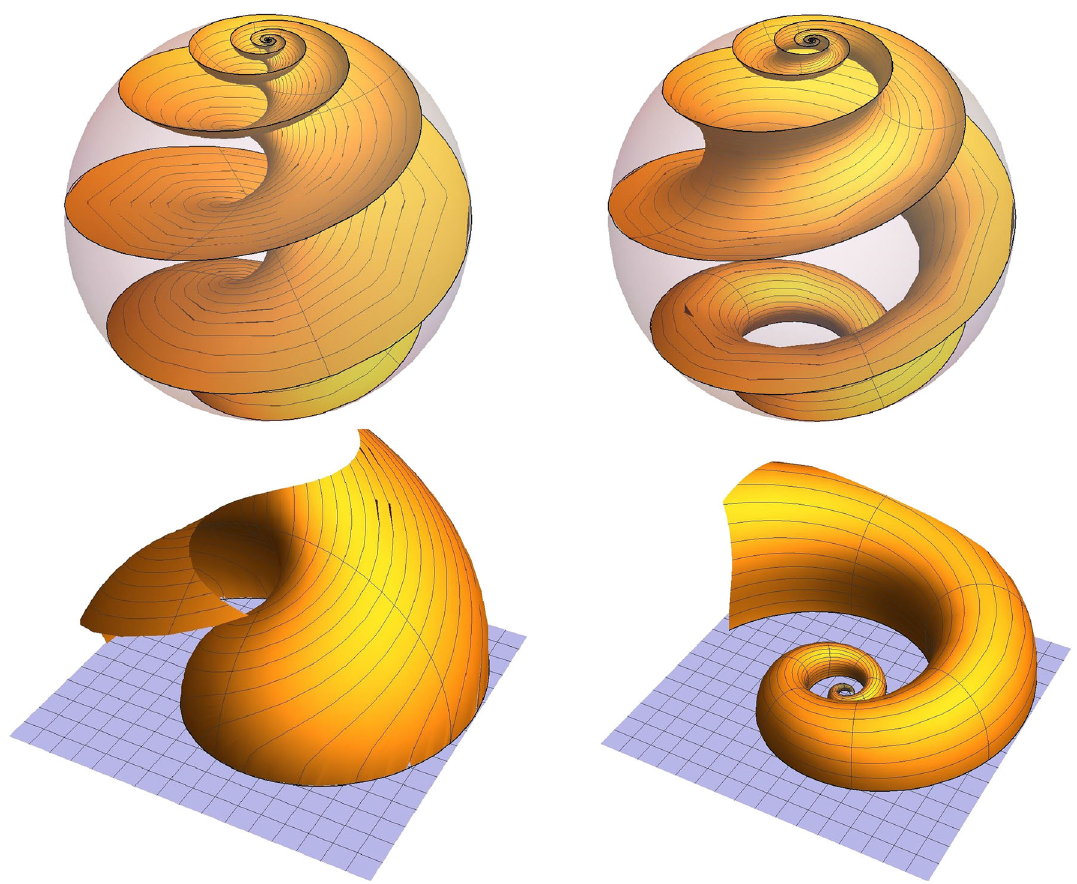
Fig. 12 Two minimal surfaces corresponding to the same boundary curve defined by ω = 1 / 4 and δϕ = π